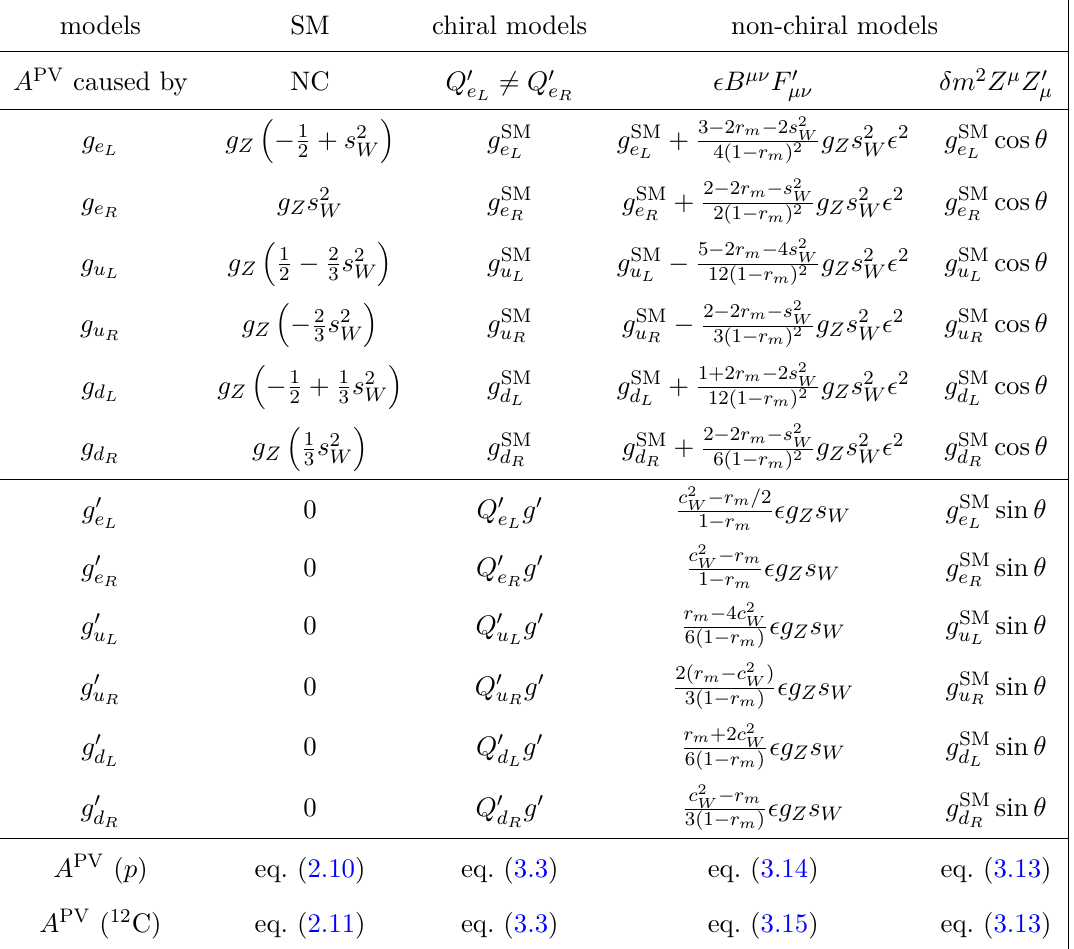
Table 1 . Analytical expressions for the effective couplings of Z and Z 0 bosons to the SM quarks and charged leptons in the SM, chiral U(1) 0 models (from Q (from the kinetic mixing (cid:15)B µν F 0 sponding analytic formulae of A PV for electron scattering off proton or 12 C. The superscript “SM” indicates SM contributions. Here g c W ≡ cos θ W ) and we have defined r m ≡ m 2